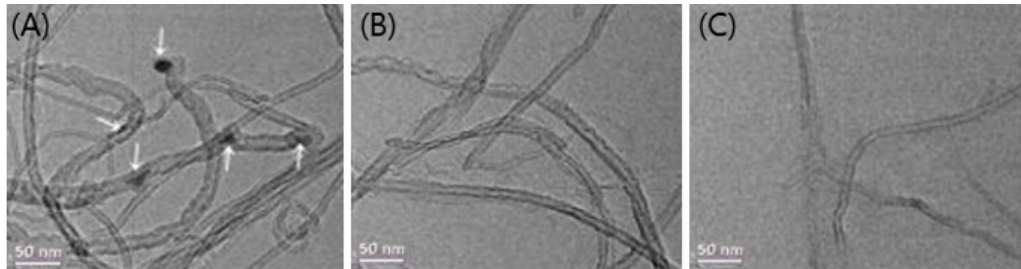
Figure 2. TEM images of the pristine and surface modified MWCNTs: ( A ) Pristine CNT, ( B ) A-CNT, ( C ) K-CNT. ( C )